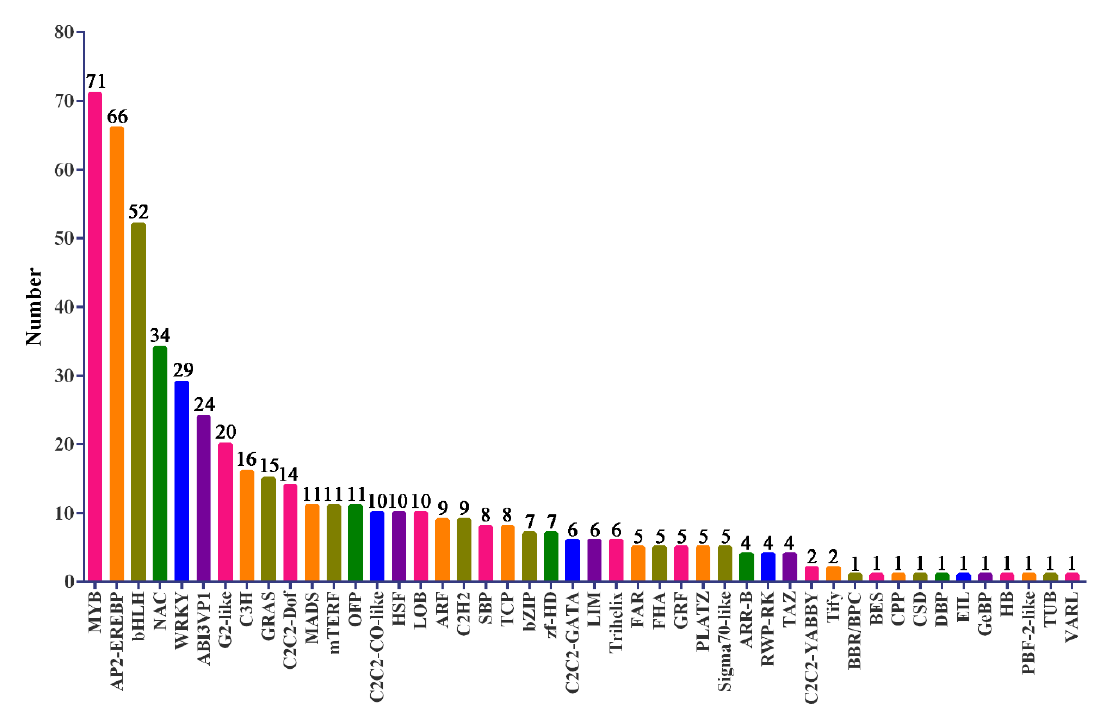
Figure 6. Family of transcription factors differentially expressed between control and SA pretreated salt stressed samples. The X axis represents a different family of transcription factors, and the Y axis represents the number of transcription factors contained in each transcription factor family. The number above the column indicates the number of transcription factors.